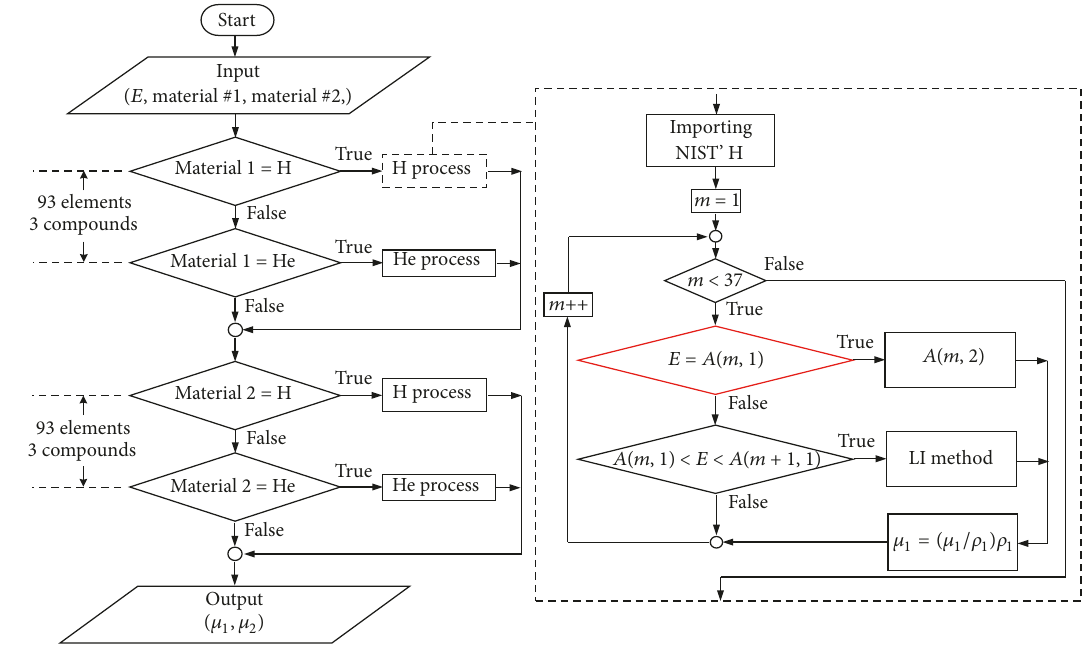
Figure 6: Flowchart of mass attenuation coefficient (𝜇/𝜌) calculation.